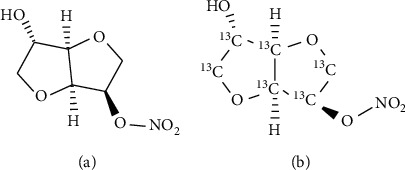
Structure of 5-ISMN (a) and 13C6-5-ISMN (b).